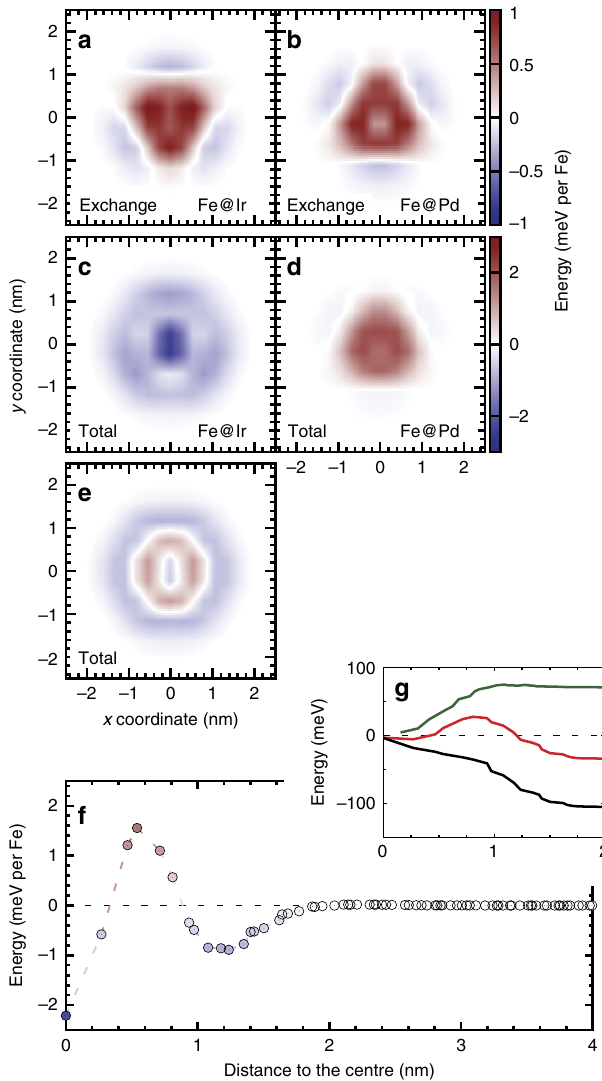
Figure 4 | Site-resolved energy contributions for a skyrmion in the multilayer Rh/Pd/2Fe/2Ir. The isolated skyrmion has been obtained at a magnetic field of B ¼ 3.5T ( cf . skyrmion profile in Fig. 3). ( a , b ) The exchange energy in the Fe layer at the Ir interface (Fe@Ir) and at the Pd interface (Fe@Pd), respectively. ( c , d ) The total energy (exchange, DMI, Zeeman and anisotropy) for the two Fe layers and ( e ) for the complete Fe bilayer. The colour scale bar of the energy is given to the right of the panels, indicating stabilizing ( E o 0) and destabilizing ( E 4 0) contributions. For ( e ), the scale bar is the same as for c , d . ( f ) Total energy per Fe atom averaged over the d th neighbour shell for e . The inset ( g ) shows the total energy summed over the shells from the skyrmion centre up to the radius r of the Fe bilayer (red), Fe@Pd (green) and Fe@Ir